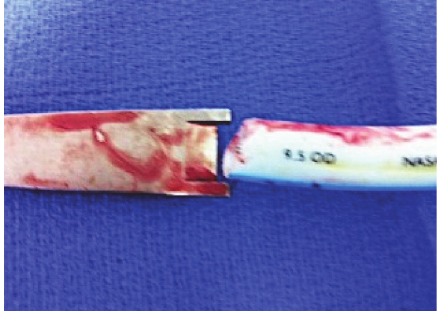
Figure 3: Relationship of size of osteotome to nasoendotracheal